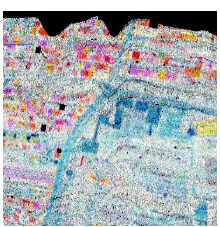
Figure 6. Subset emissivity ( RGB = 9 . 36 , 10 . 33 , 11 . 30 µm ).